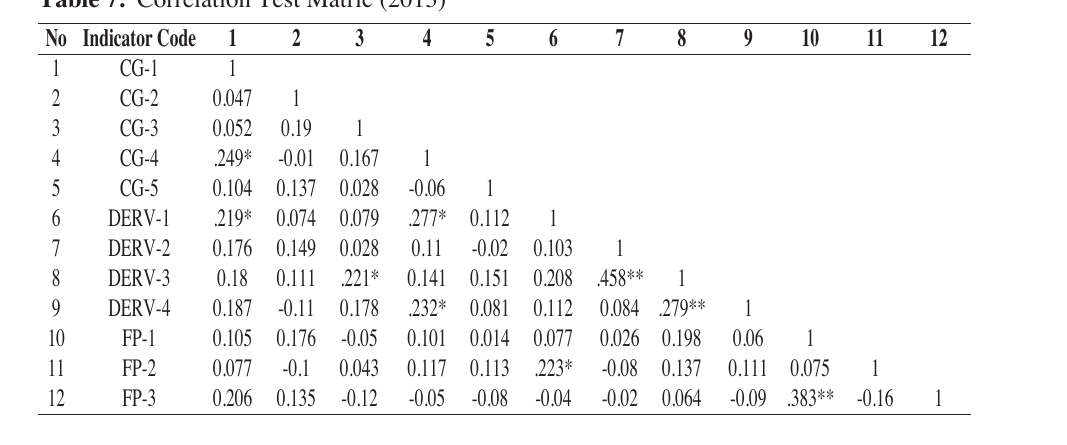
Table 8. Correlation Test Matric